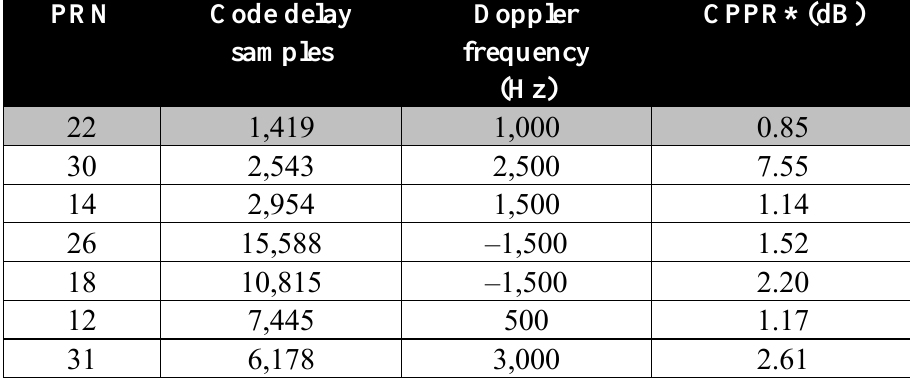
Table 4. The acquisition result of the collected indoor signal by using the conventional acquisition method with 1 ms integration time and applying the SEV